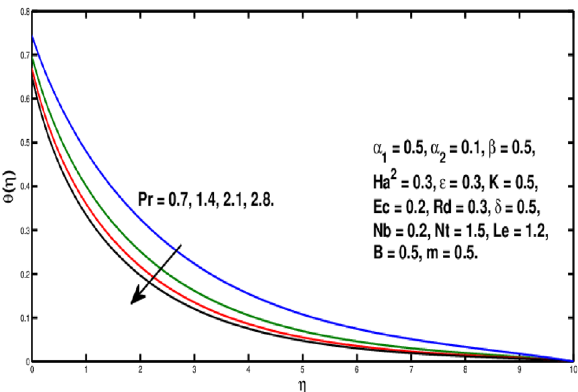
Figure 5. Variation of Ha